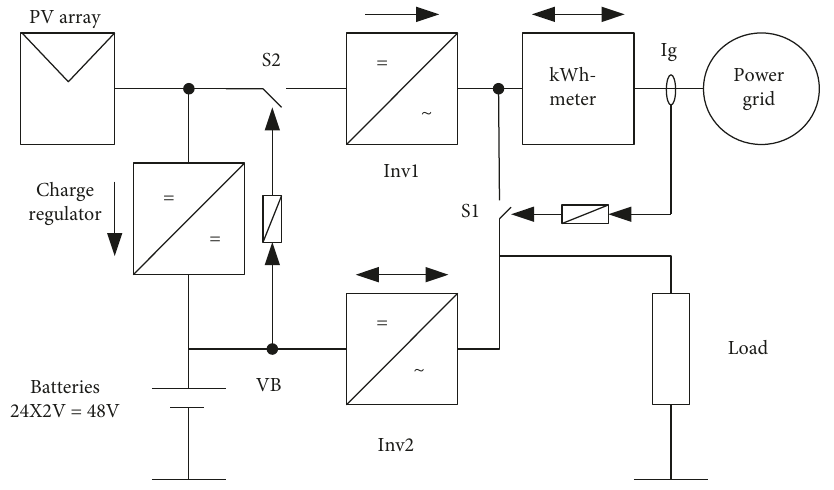
Figure 1: Schematic diagram of the proposed PV backup